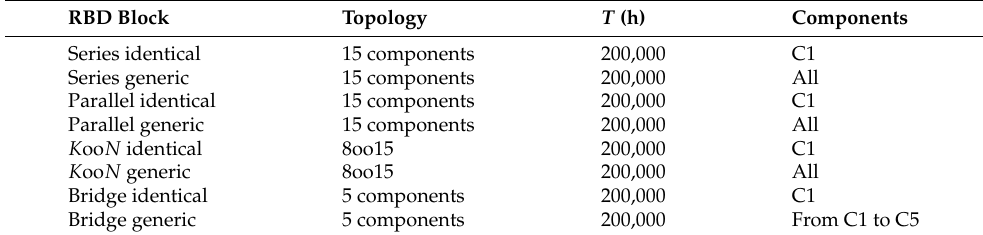
Table 2. RBD models used during